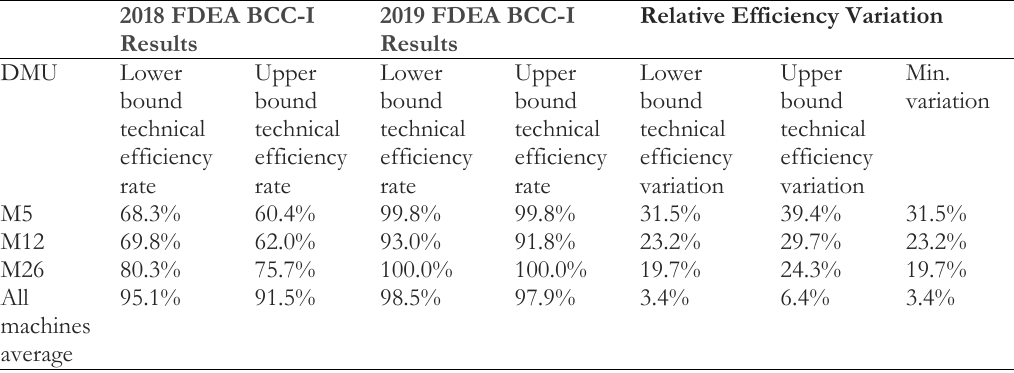
Table 8. BCC-input oriented FDEA results and efficiency